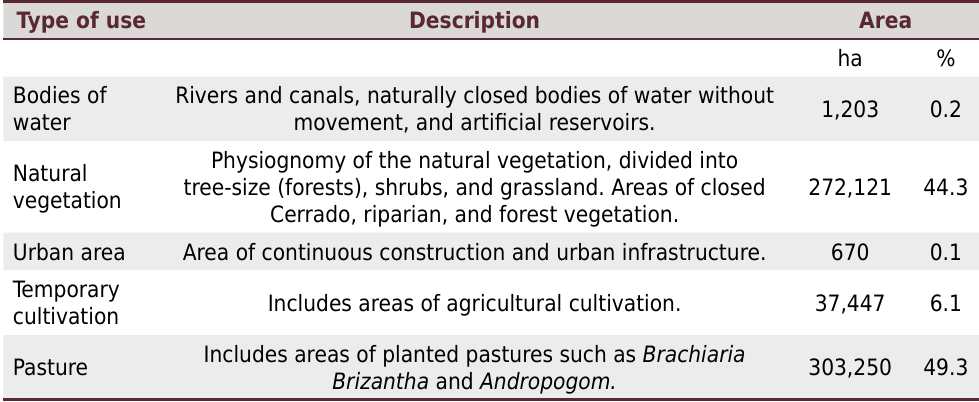
Table 8. Description of the types of soil present in the municipality of São Miguel do Araguaia, state of Goiás, Brazil Type of use